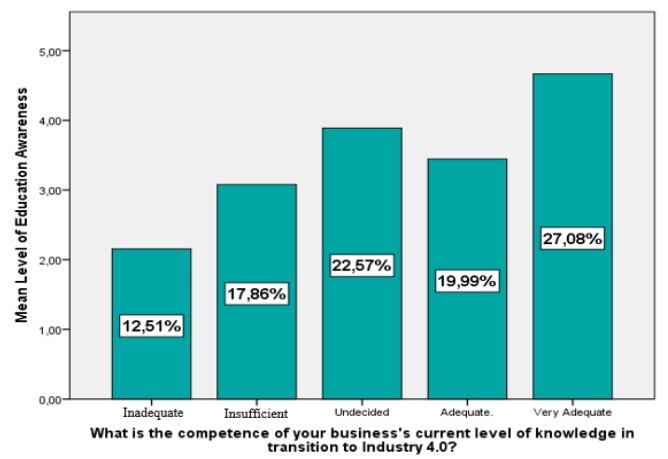
Fig. 4. Educational awareness distribution based on Industry 4.0